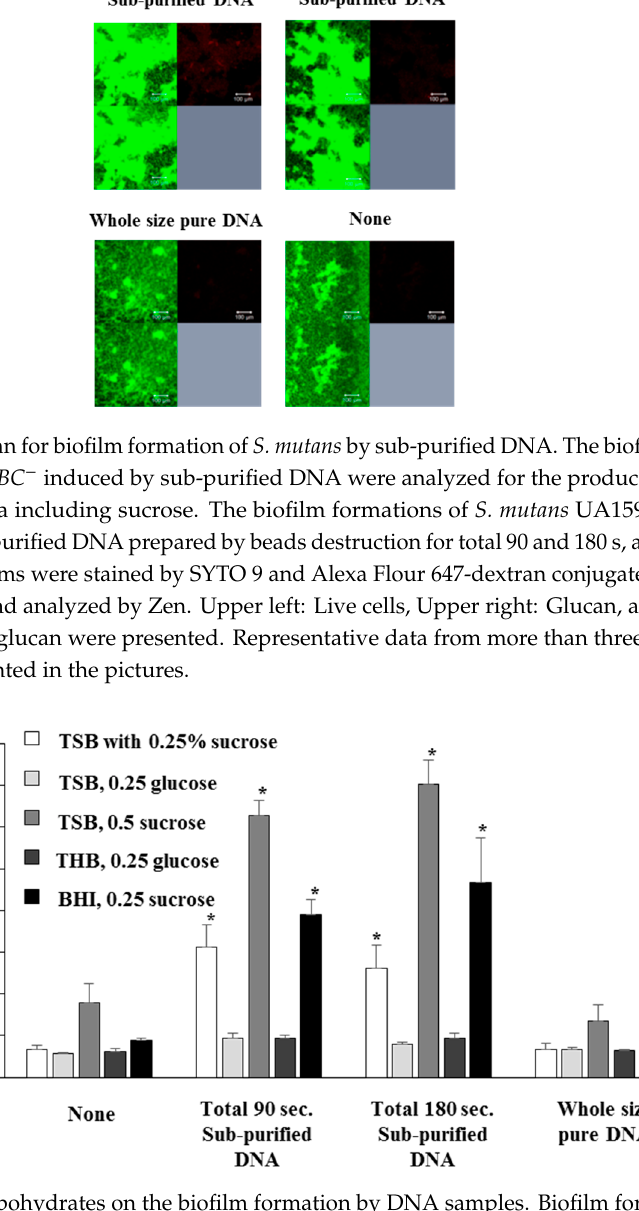
Figure 3. E ff ects of carbohydrates on the biofilm formation by DNA samples. Biofilm formations were quantitatively assessed in none, sub-purified DNA prepared by beads destruction for a total of 90 and 180 s, and whole-size pure DNA in TSB with 0.25% sucrose, 0.25% glucose, and 0.5% sucrose, THB with 0.25% glucose, and BHI with 0.25% sucrose. The data indicate the mean ± standard deviation (SD) of triplicate experiments. The independent experiments were performed three times, with similar results obtained in each. The asterisks indicate a significant di ff erence between the two groups (*: p < 0.05, no DNA vs. DNA).